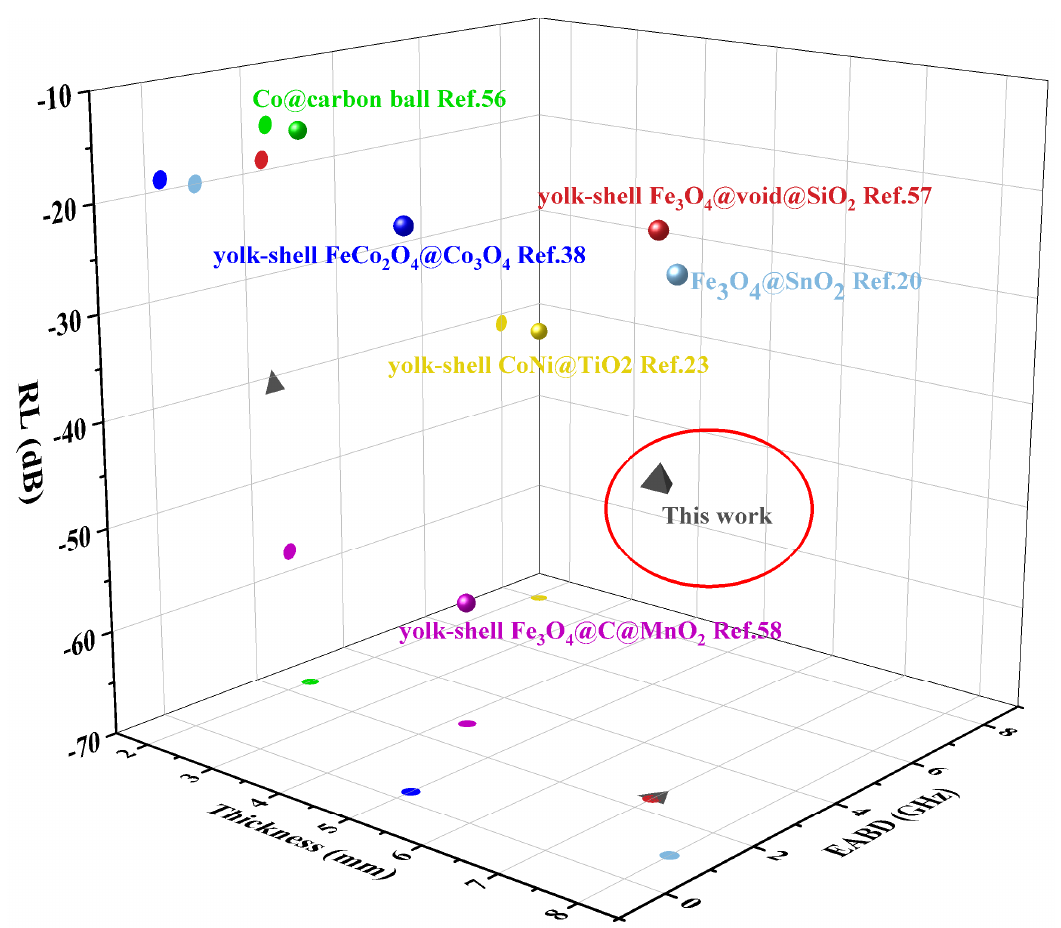
Figure 8. Microwave absorption performance of yolk–shell Co@C composites compared with that of other reported yolk–shell composites.